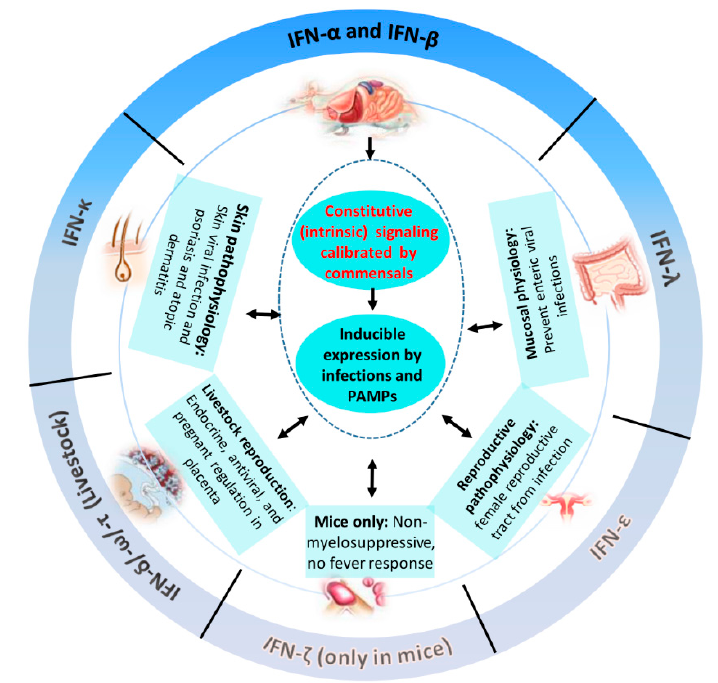
Figure 3. Schematic of an incomplete list of the known and unknown functional properties about porcine IFNs. While porcine innate immune IFNs conserve the canonical functions such as inductive expression upon viral infections to exert roles in antiviral / antitumor / Immune activity as revealed using typical IFN α / β subtypes, some other critical role, such as intrinsic regulation over microbiota-host homeostasis, or subtype-specific activity particularly that relates to the livestock-specific unconventional subtypes in antiviral and physiological regulation, have not been investigated in pigs. In addition, both pigs and cattle have evolved the most complicate IFN-complex that remains largely unstudied per functional and signaling specificity compared with that revealed using the canonical IFN α / β in mice.